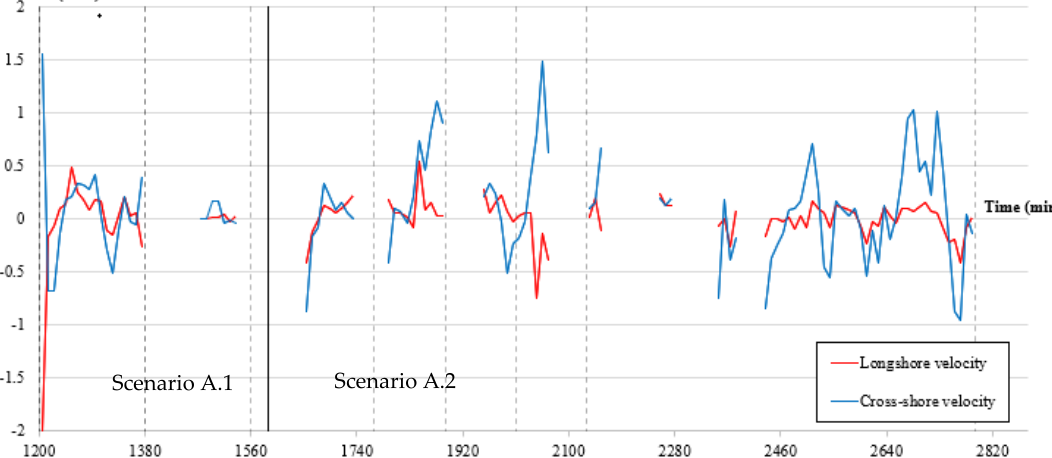
Figure 4. Recorded data timeline for the longshore and cross-shore velocity for the A.1 and A.2 scenarios. The vertical black line represents the transition between scenarios A.1 and A.2. The ver-tical black dashed lines represent the instants when the equipment was stopped.